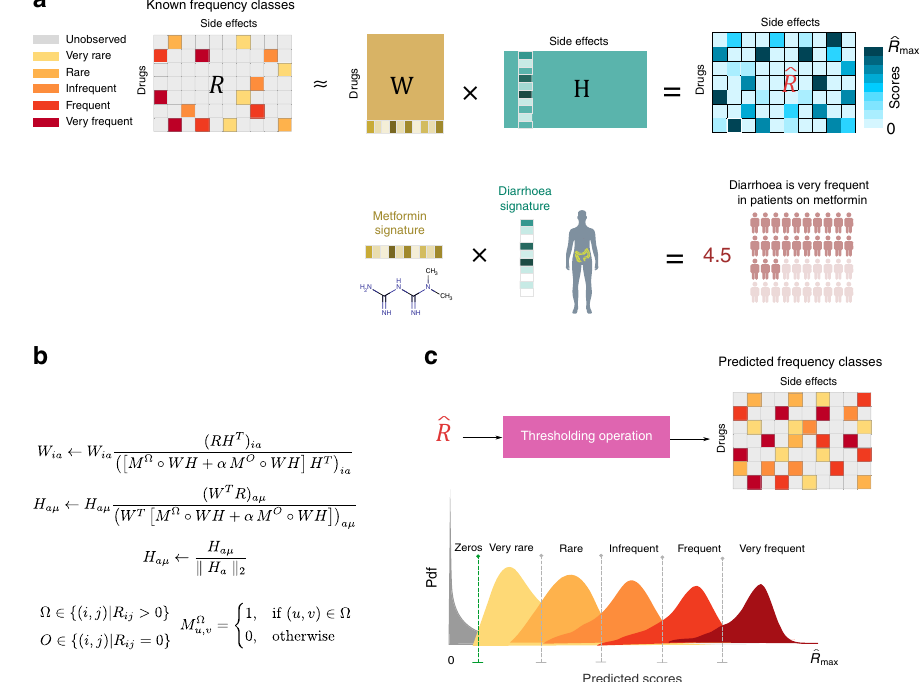
Fig. 2 Overview of our approach. a Thirty-seven thousand four hundred and forty-one known frequency associations for 759 therapeutically diverse drugs and 994 side effects from all human physiological systems were collected from the SIDER 4.1 database. The associations were standardised into the fi ve frequency classes commonly used in randomised controlled trials and arranged into an n × m matrix R by encoding them using integers: very rare ( = 1), rare ( = 2), infrequent ( = 3), frequent ( = 4) and very frequent( = 5). Unobserved associations were encoded with zeros. Our algorithm decomposes the matrix R into the product of two matrices, W (of size n × k ) and H (of size k × m ). By multiplying the matrices W and H , we obtain ^ R , which models R , and where all the integers are replaced by real numbers — these are our predicted scores. Note that values that replace the zeros in R will constitute our predictions. Rows of W are the drug feature vectors (drug signature); columns of H are the side effect feature vectors (side effect signature). The lower illustration depicts how our model discovers a low-dimensional signature vector for the anti-diabetic drug Metformin and a low-dimensional signature vector for the side effect diarrhoea, such that the dot product of these two signatures models the frequency of diarrhoea in patients on Metformin. The body parts infographic vector was created by macrovector — www.freepik.com. b Starting from non-negative initial conditions for W and H , iterations of these update rules fi nd W and H , an approximate factorisation for R by converging to a local minimum of the objective function in Eq. (1). c Frequency classes were obtained from ^ R using a thresholding operation. Thresholds are set by maximum likelihood using likelihood density functions for each class that are estimated during cross-